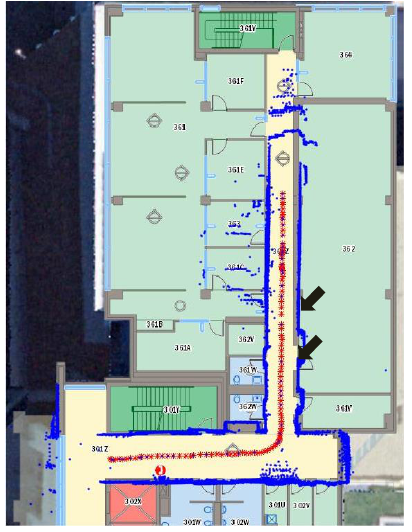
Figure 8. Mapping and position results of the RKF algorithm.